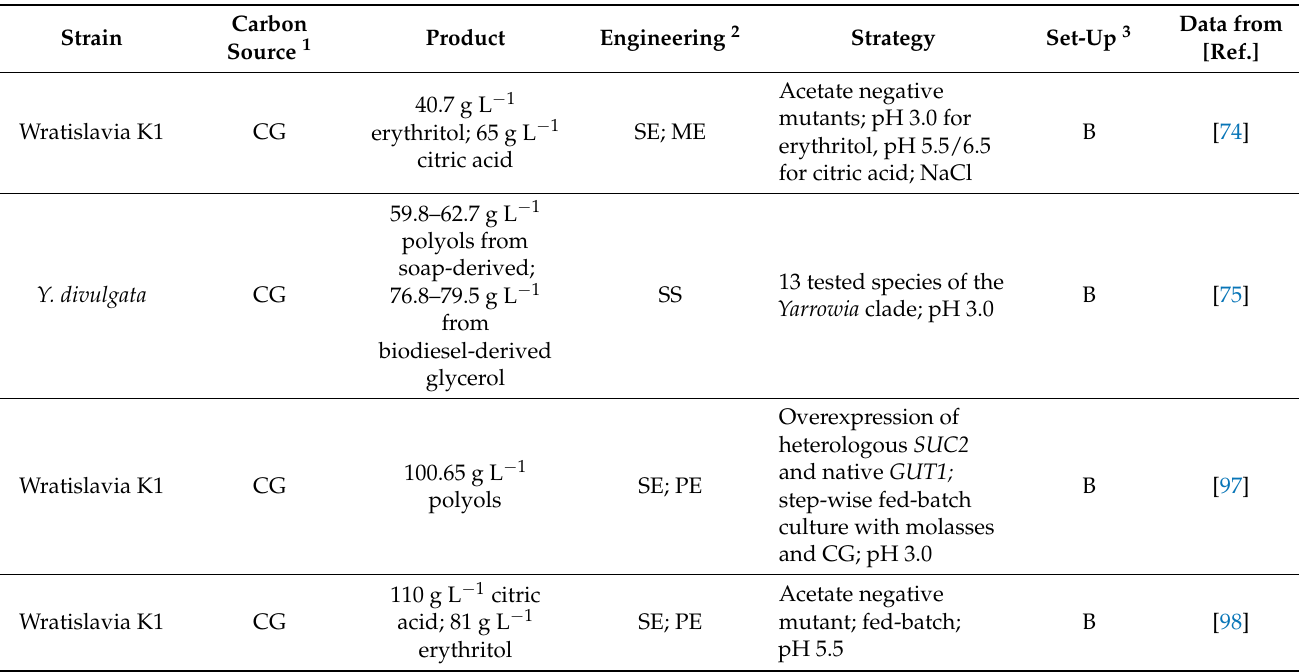
Table 3. Engineering strategies (strain, medium, process) and cultivation systems using pure or crude glycerol as carbon source for the production of polyols by Y. lipolytica